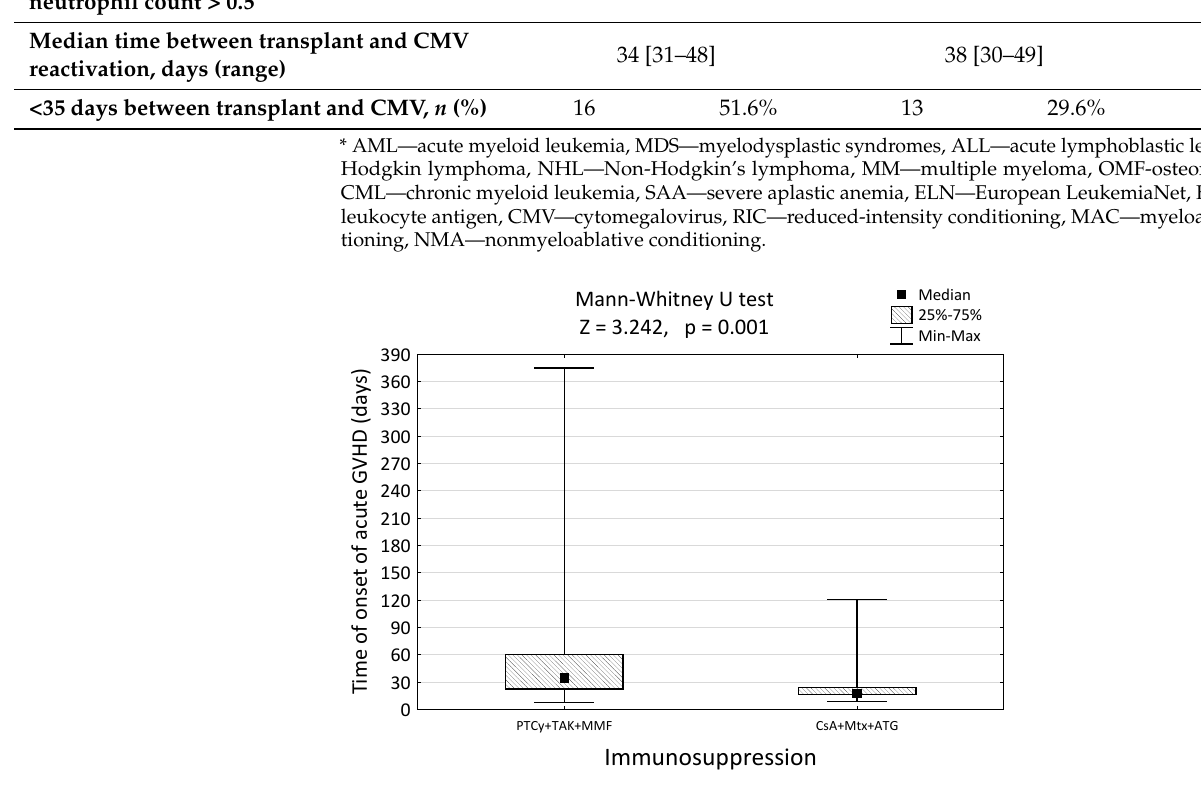
Figure 1. Time of onset of acute GvHD (days) in patients receiving either PTCy + TAK + MMF or CsA + MTX + ATG and the results of significance tests. Table 3. The characteristics of patients differing by the presence of acute GvHD in a study popula- tion (in red: p < 0.005).